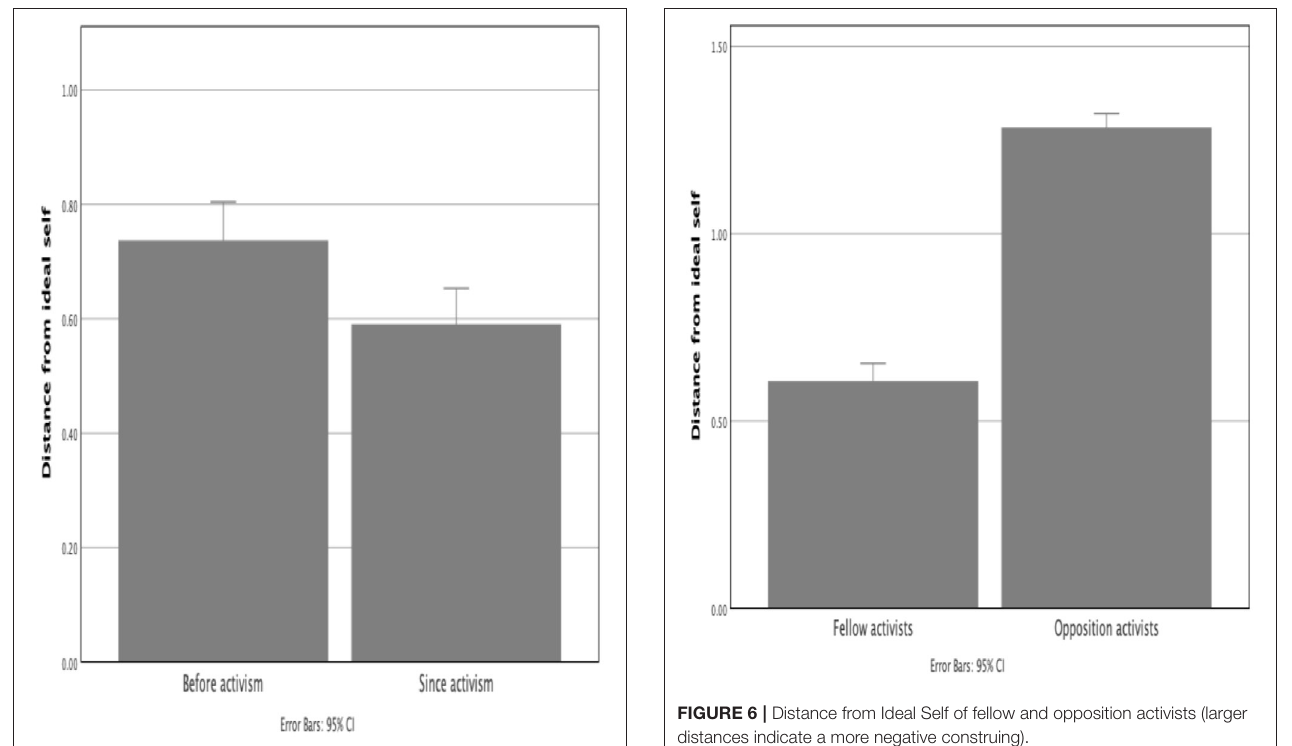
FIGURE 5 | Distance from Ideal Self of participants before and after they become activists (smaller distances indicate a more favorable construing).